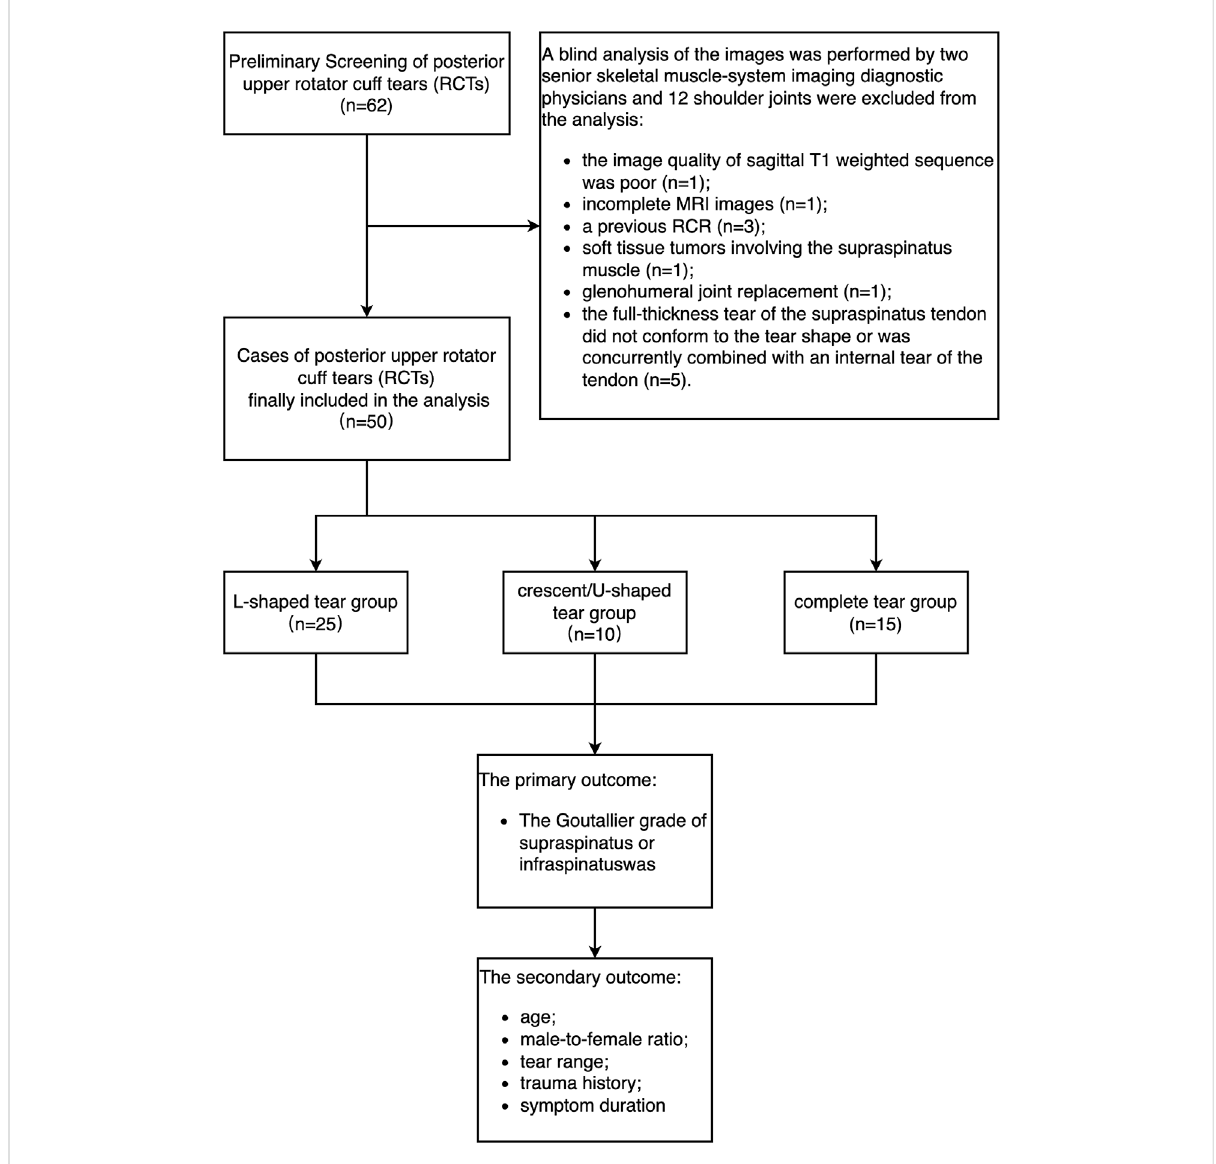
FIGURE 6 The fl ow-diagram of enrollment and observational outcomes.